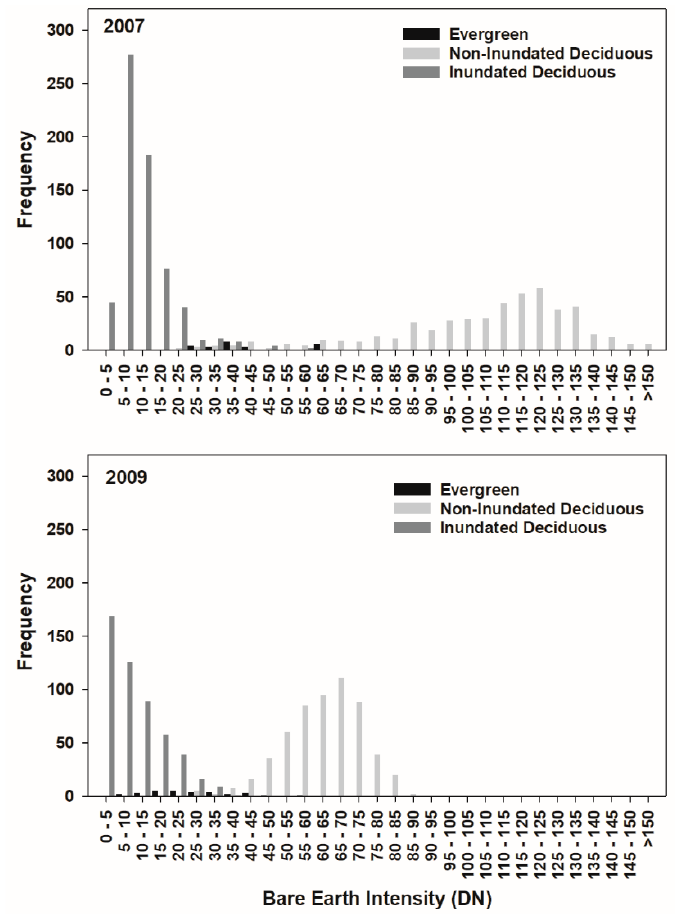
Figure 3. Frequency distributions plotted at 5 digital number (DN) intervals depicting 27 March, 2007 ( top ) and 24 March, 2009 ( bottom ) bare earth return values extracted for in situ data points, including evergreen, inundated deciduous, and non-inundated deciduous points. All evergreen points were